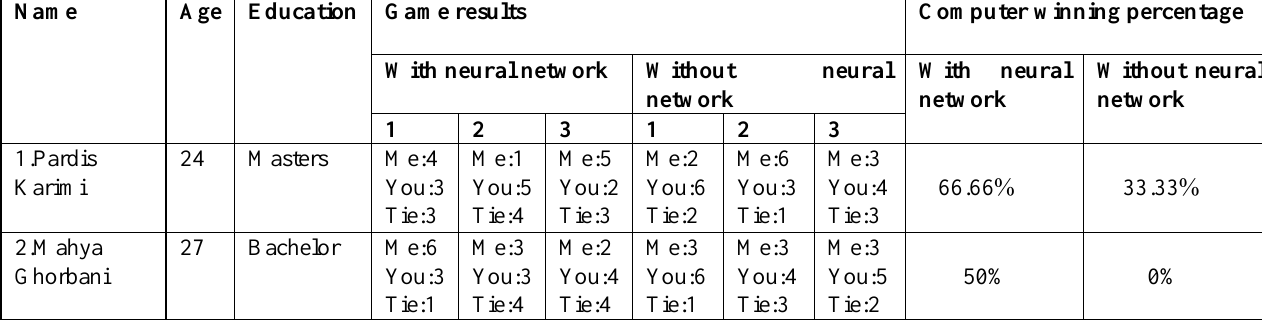
Game results and computer winning percentage in women with and without the neural network.